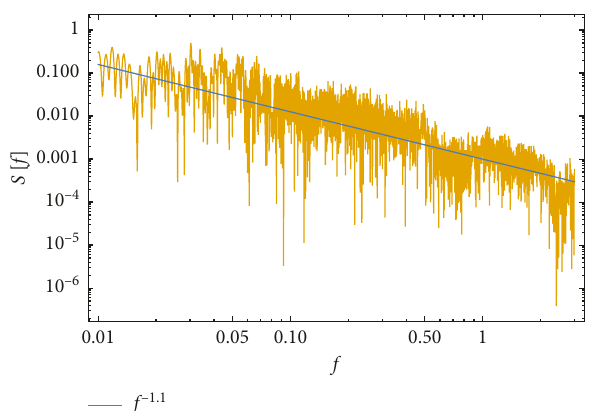
Figure 2: Log-log plot of the PSD for τ � 1000, and S I